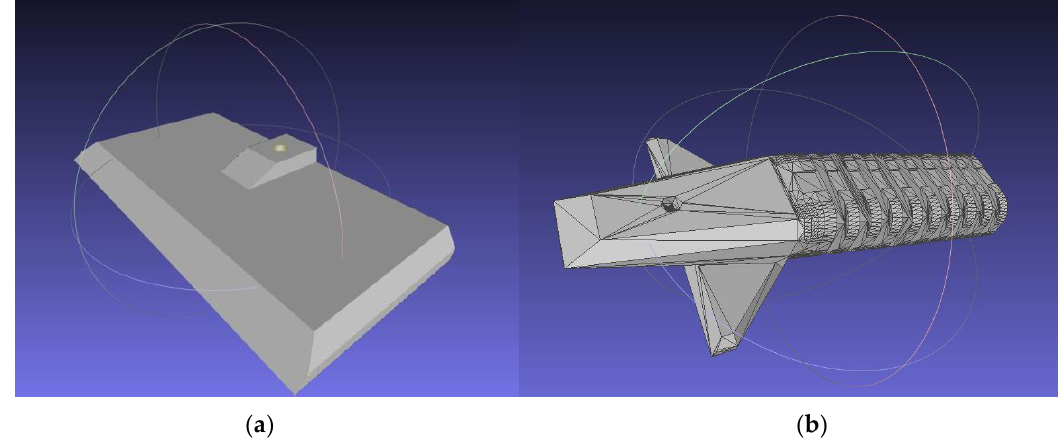
Figure 10. Meshlab rendering of STLs for ( a ) blade and ( b ) handle of snow scraper.